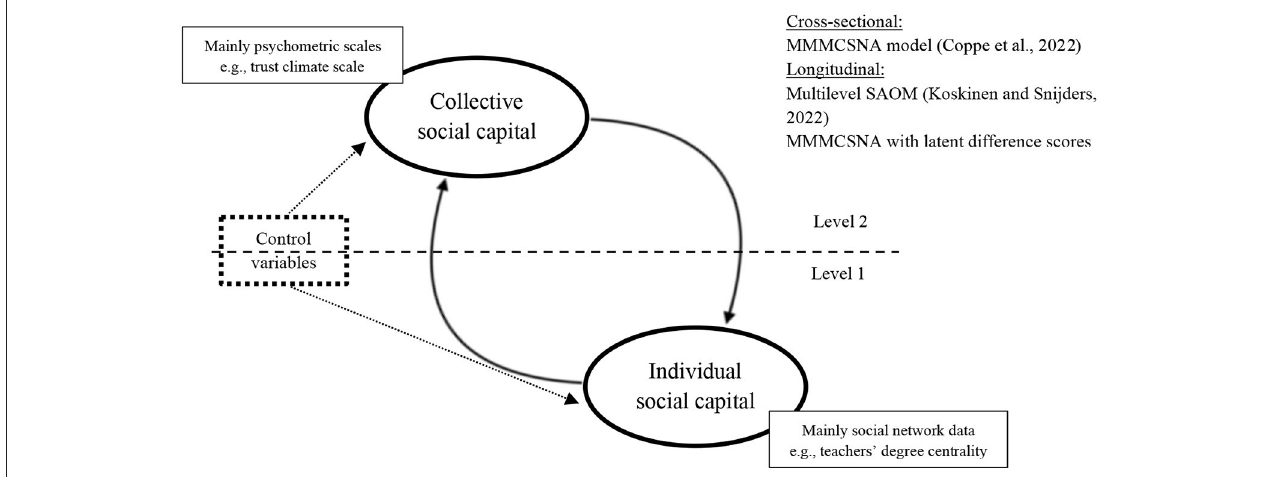
FIGURE 2 | Analytical model for testing the relationship between individual and collective social capital. Outcome variable can be added. Individual or collective social capital would be then considered as mediator between collective/individual social capital and the outcome.